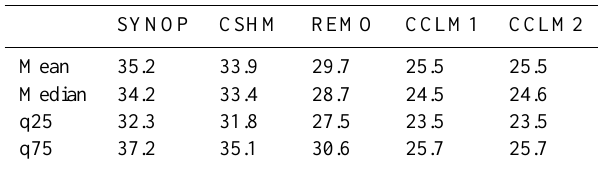
Table 3. Statistical parameters of the distribution of the gust wind speeds from SYNOP, CSHM, REMO, CCLM1 and CCLM2 data with mean and 25th, 50th, and 75th percentiles of the distribution function (q25, median, q75) in ms − 1